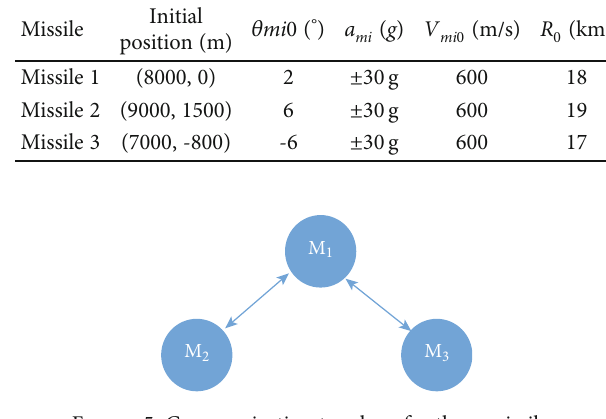
Figure 5: Communication topology for three missiles.